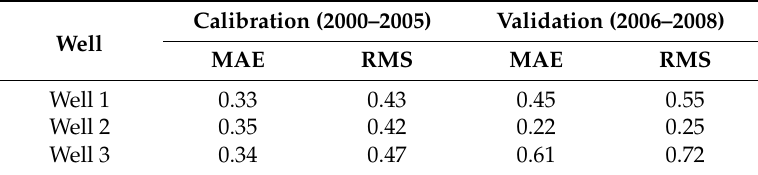
Table 9. The statistical result between the simulation and observation of three of fifteen wells.